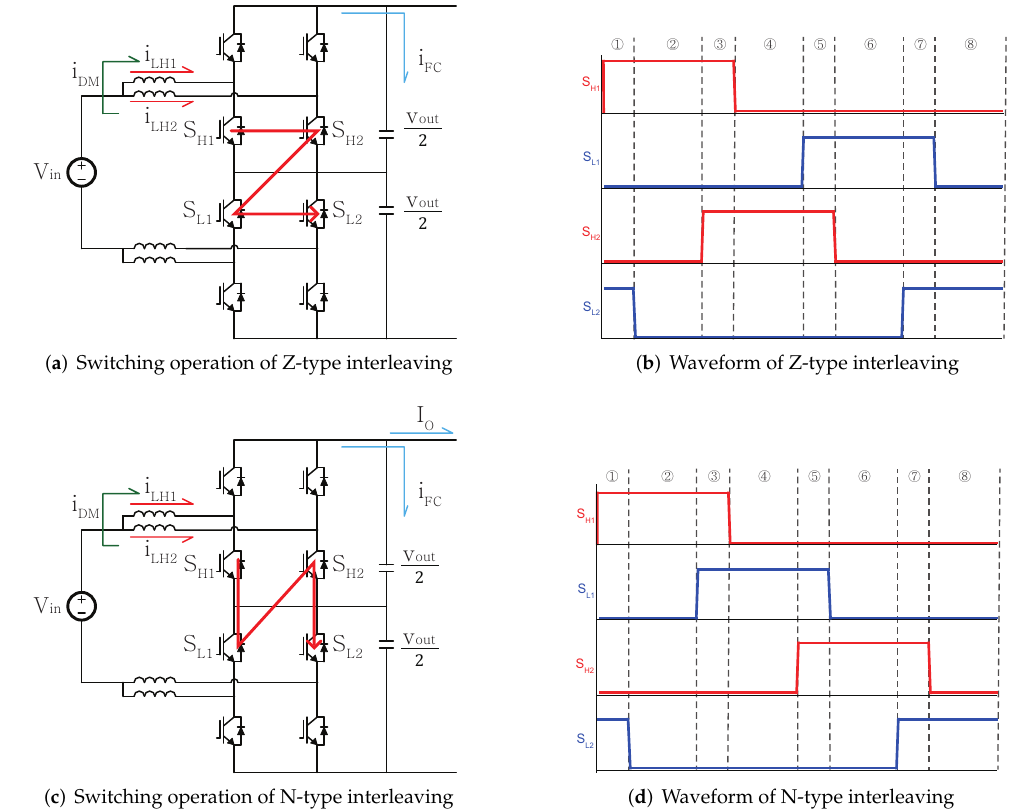
Figure 3. Switching operation according to interleaving